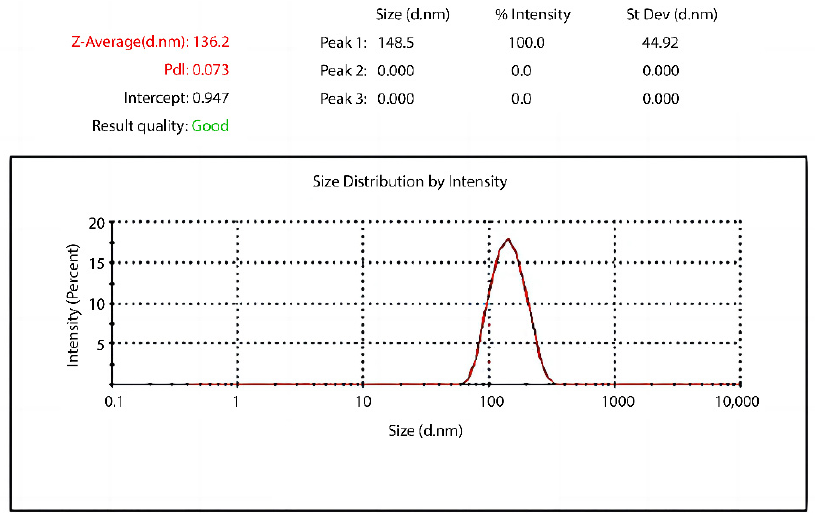
Figure 3. Laser particle size analysis of acrylic acid dispersion.